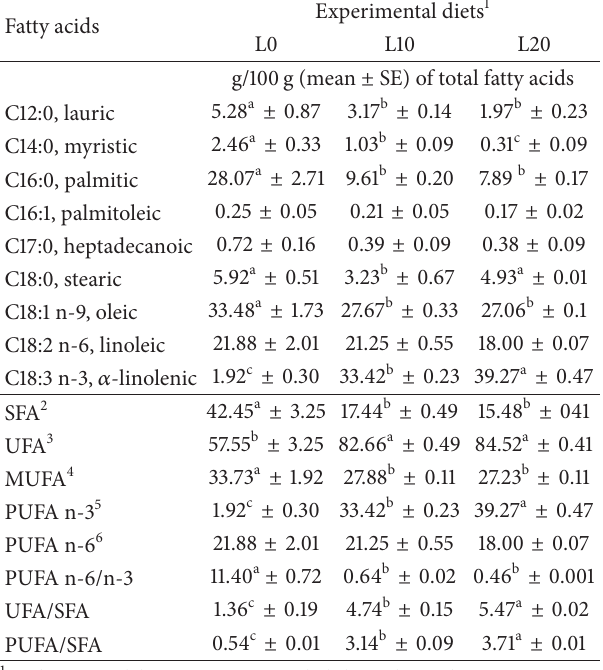
Table 2: Fatty acid composition of the experimental diets. Fatty